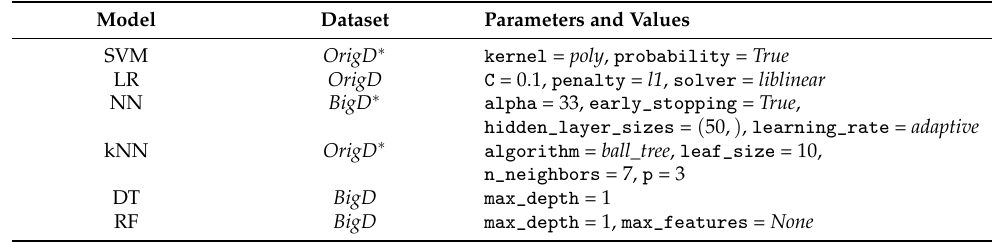
Table 9. Best values of the meta-parameters for each